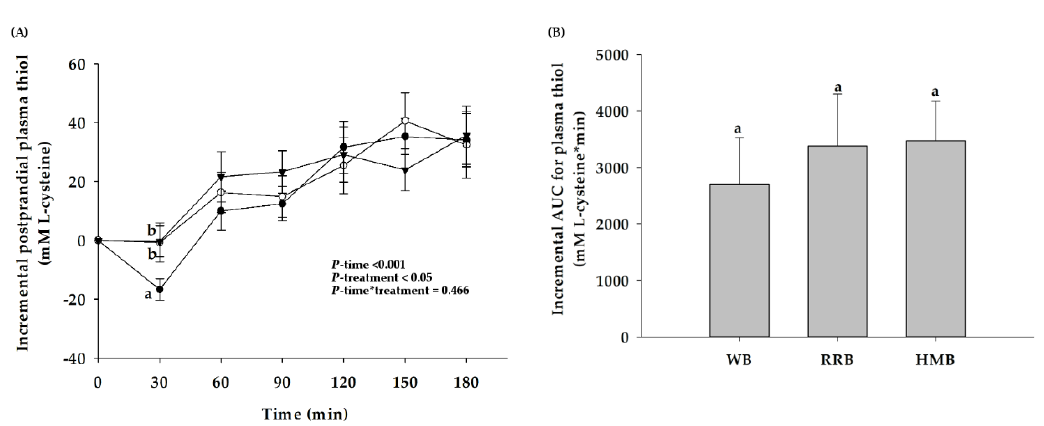
Figure 8. ( A ) Changes in postprandial thiol level and ( B ) the iAUCs for plasma thiol level of healthy participants after the consumption of wheat bread (WB), Riceberry rice bread (RRB), and Hom Mali bread (HMB). All values are means ± SEM, n = 16. WB (●), RRB ( ○ ), and HMB ( ▼ ). For each time point, means with a different letter are significantly different, p < 0.05.